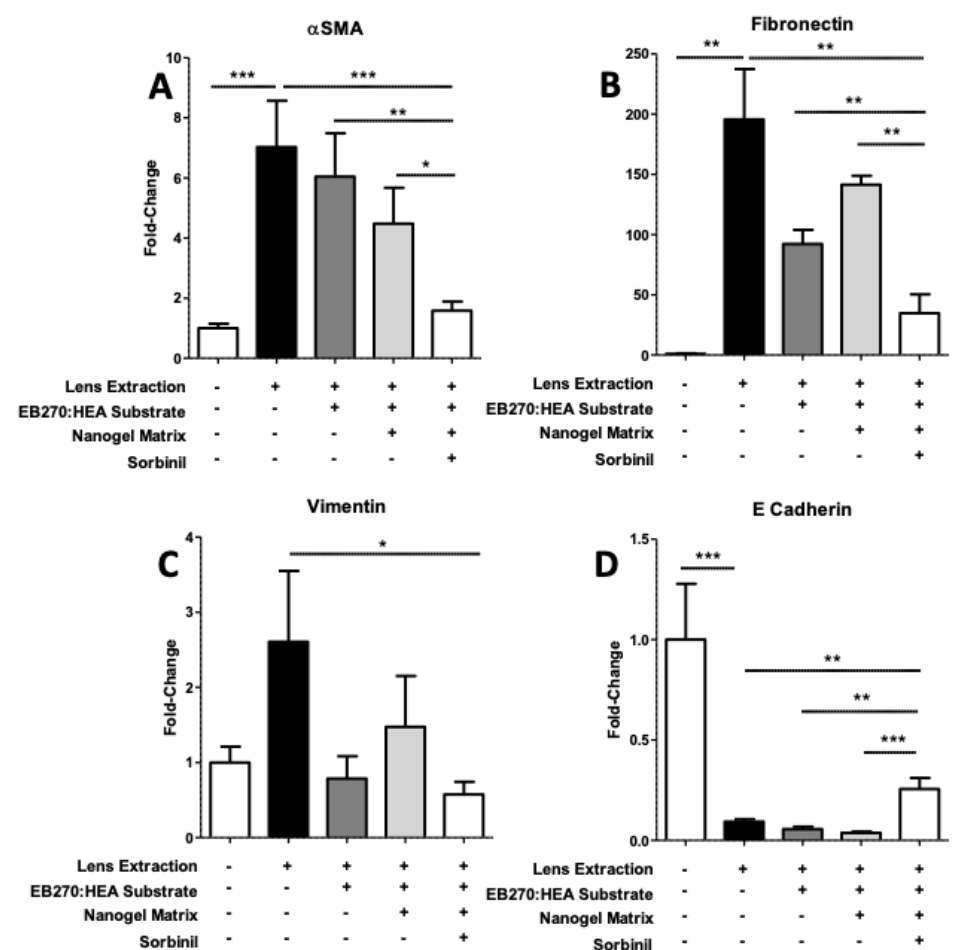
Figure 4. Influence of cataract inhibitor delivery system components on expression of EMT marker genes in lens capsule-epithelium. Marker genes included α SMA ( A ), fibronectin ( B ), vimentin ( C ) and E-cadherin ( D ). Presence of components arrayed beneath each reading is indicated by “+”. The degree of statistical significance of differences among comparison groups is given using one-tailed Student t -test, where *** p < 0.001, ** p < 0.01, and * p < 0.0 ( n = 3 for each set of conditions, repeated ≥ 3 times).